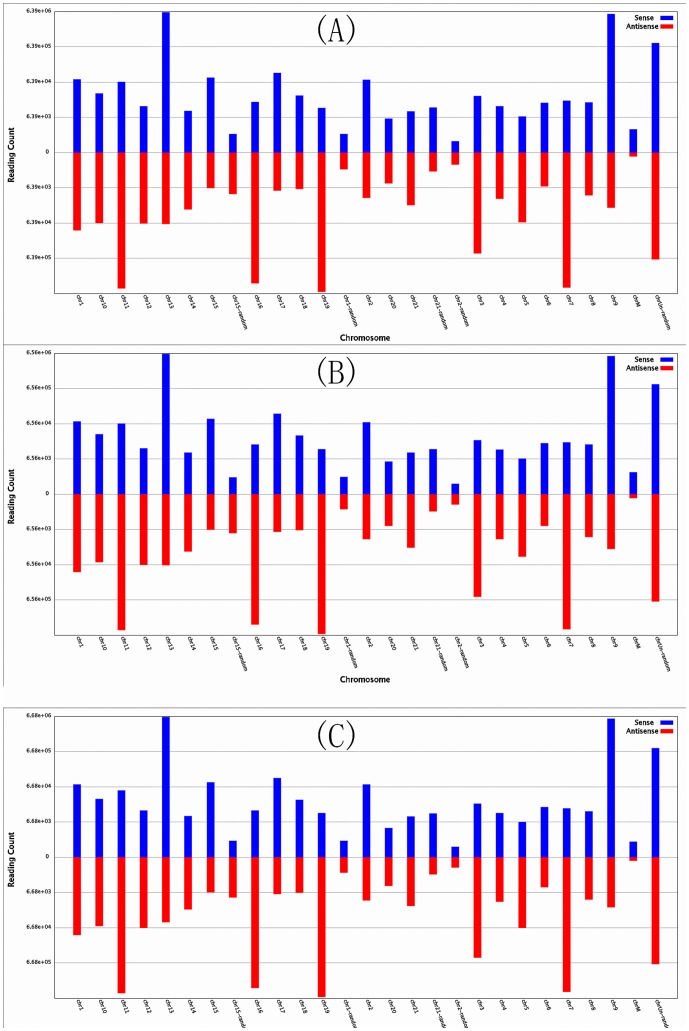
Small RNA tags matched to the genome by SOAP.The figure shows the expression and genomic distribution of miRNAs identified in the (A) Sp-con, (B) Sp-γ1, (C) SP-γ2 groups.